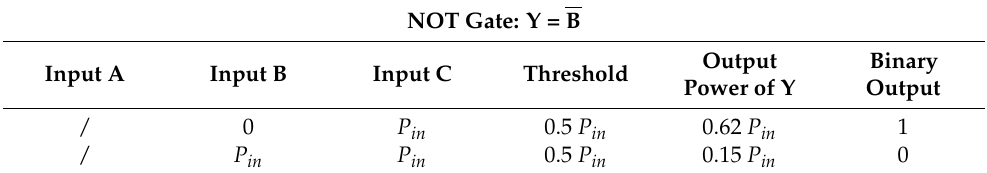
Table 3. Photonic NOT logic gate power and binary output truth table data.